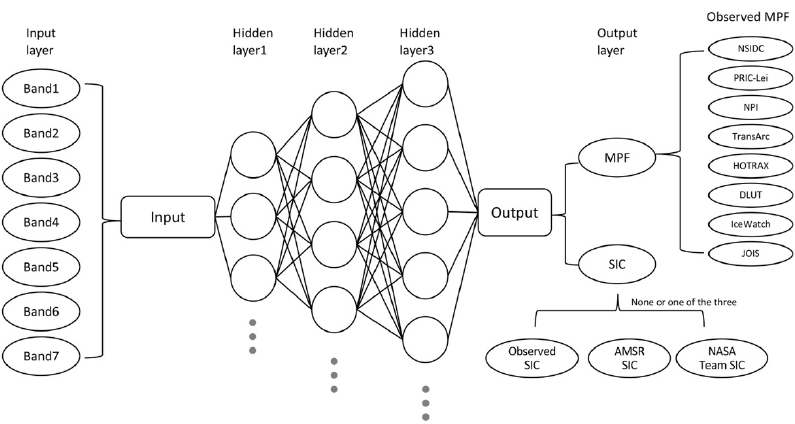
Figure 2. The structure of the DNN for the MPF retrieval.